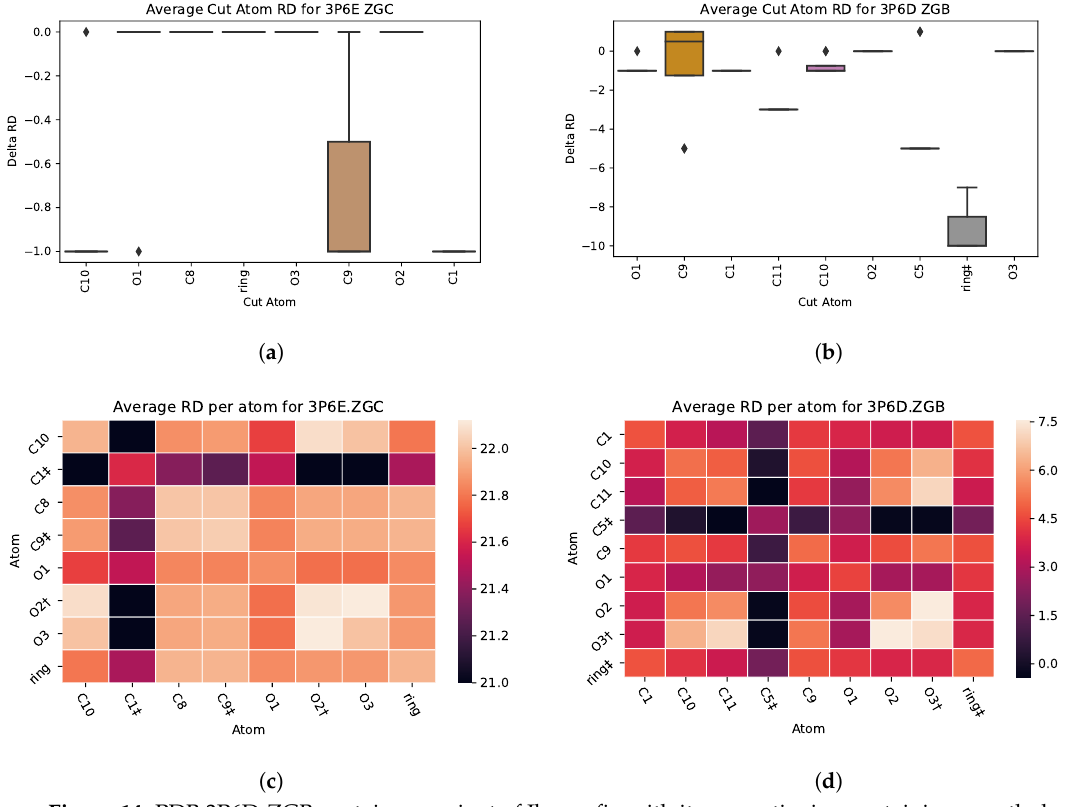
Figure 14. PDB 3P6D-ZGB contains a variant of Ibuprofin with its aromatic ring containing a methyl group ( SingleCut in ( a ), PairCut in ( c )), while PDB 3P6E-ZGC does not include the methyl group ( SingleCut in ( b ), PairCut in ( d